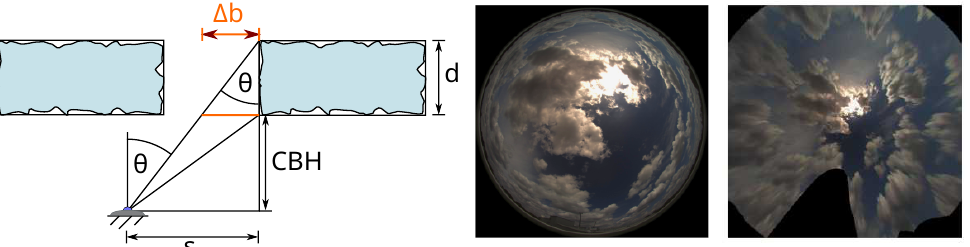
Figure A1. Left: The uncertainty of cloud edge positions ∆ b is estimated from the ASI’s perspective on clouds with a cloud thickness d observed under zenith angle θ . Center: Exemplary sky image from ASI UOL, taken at 5 June 2020 10:22:00, featuring clouds at various zenith angles; for large zenith angles, rather the side faces of clouds than their bottom sides are viewed, causing the impression of increased cloud coverage in these areas of the sky. Right: Undistorted ASI image (UOL, 5 June 2020 10:22:00) treated as a view of the cloud bottom sides by the ASI-based approaches. For the merging procedure, these considerations should be expressed